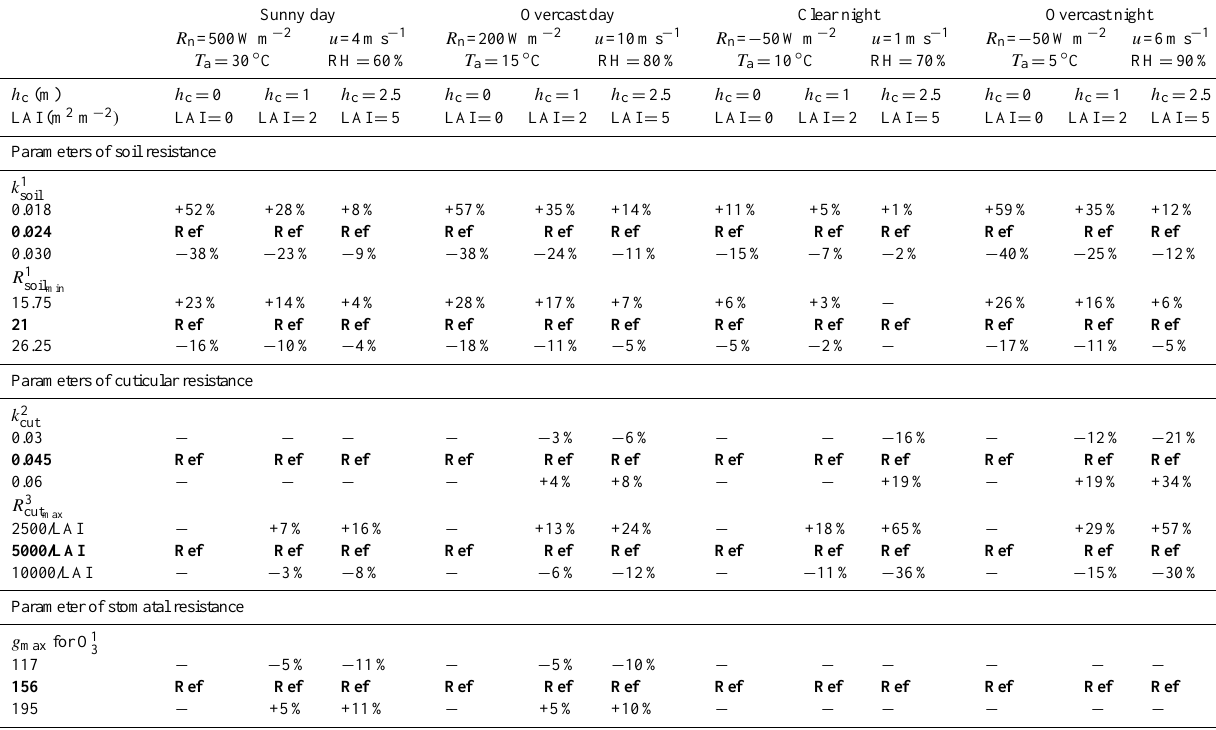
Table 4. Response of modelled ozone fluxes to parameters of ozone deposition resistances. Blank cases correspond to relative differences lower than 1%. Bold cases correspond to the reference values. The reference height is